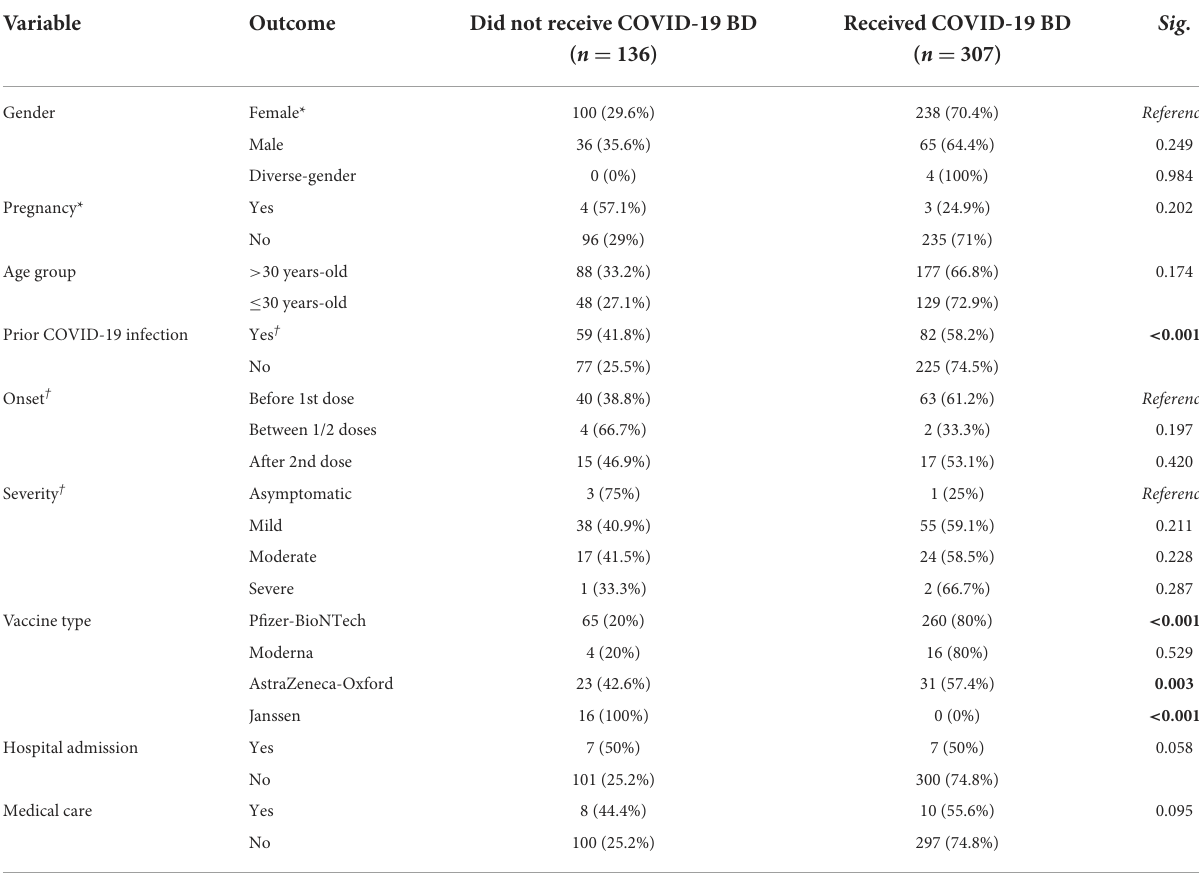
TABLE 6 Demographic and anamnestic determinants of COVID-19 vaccine booster uptake among polish healthcare professionals and students responding to COVID-19 VBH survey, December 2021–January 2022 ( n = 443). Variable